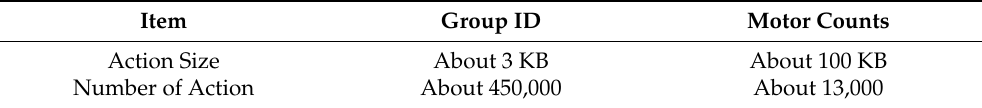
Table 2. Different format